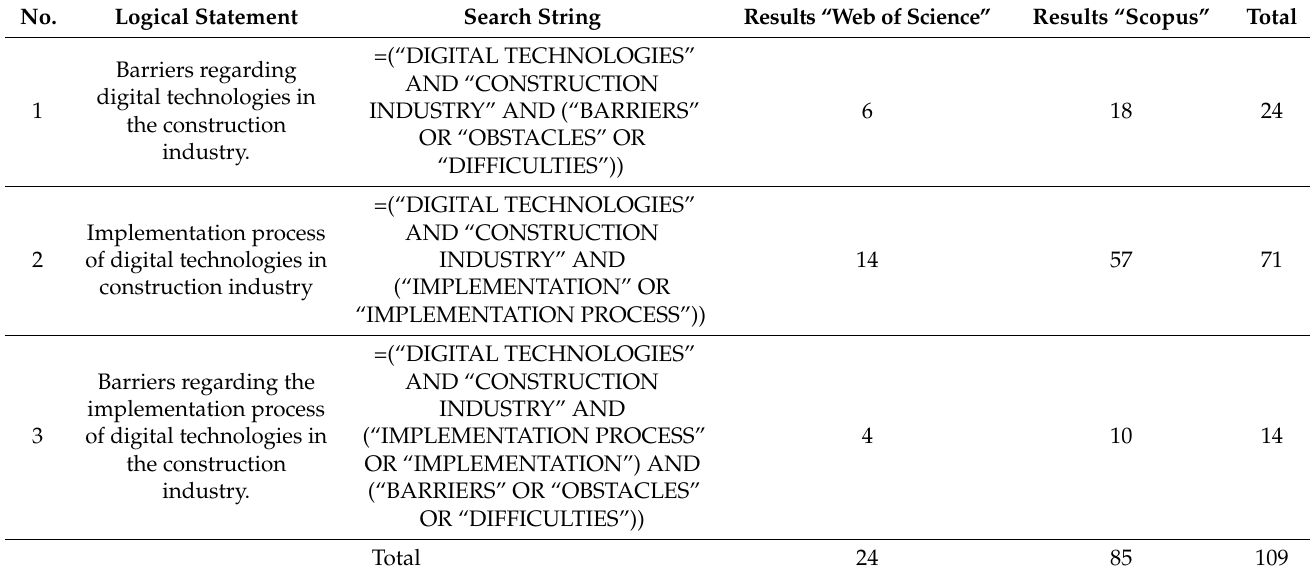
Table 1. The logical statement, the corresponding search strings and the results from the databases Web of Science and Scopus (date of extraction: 10 February